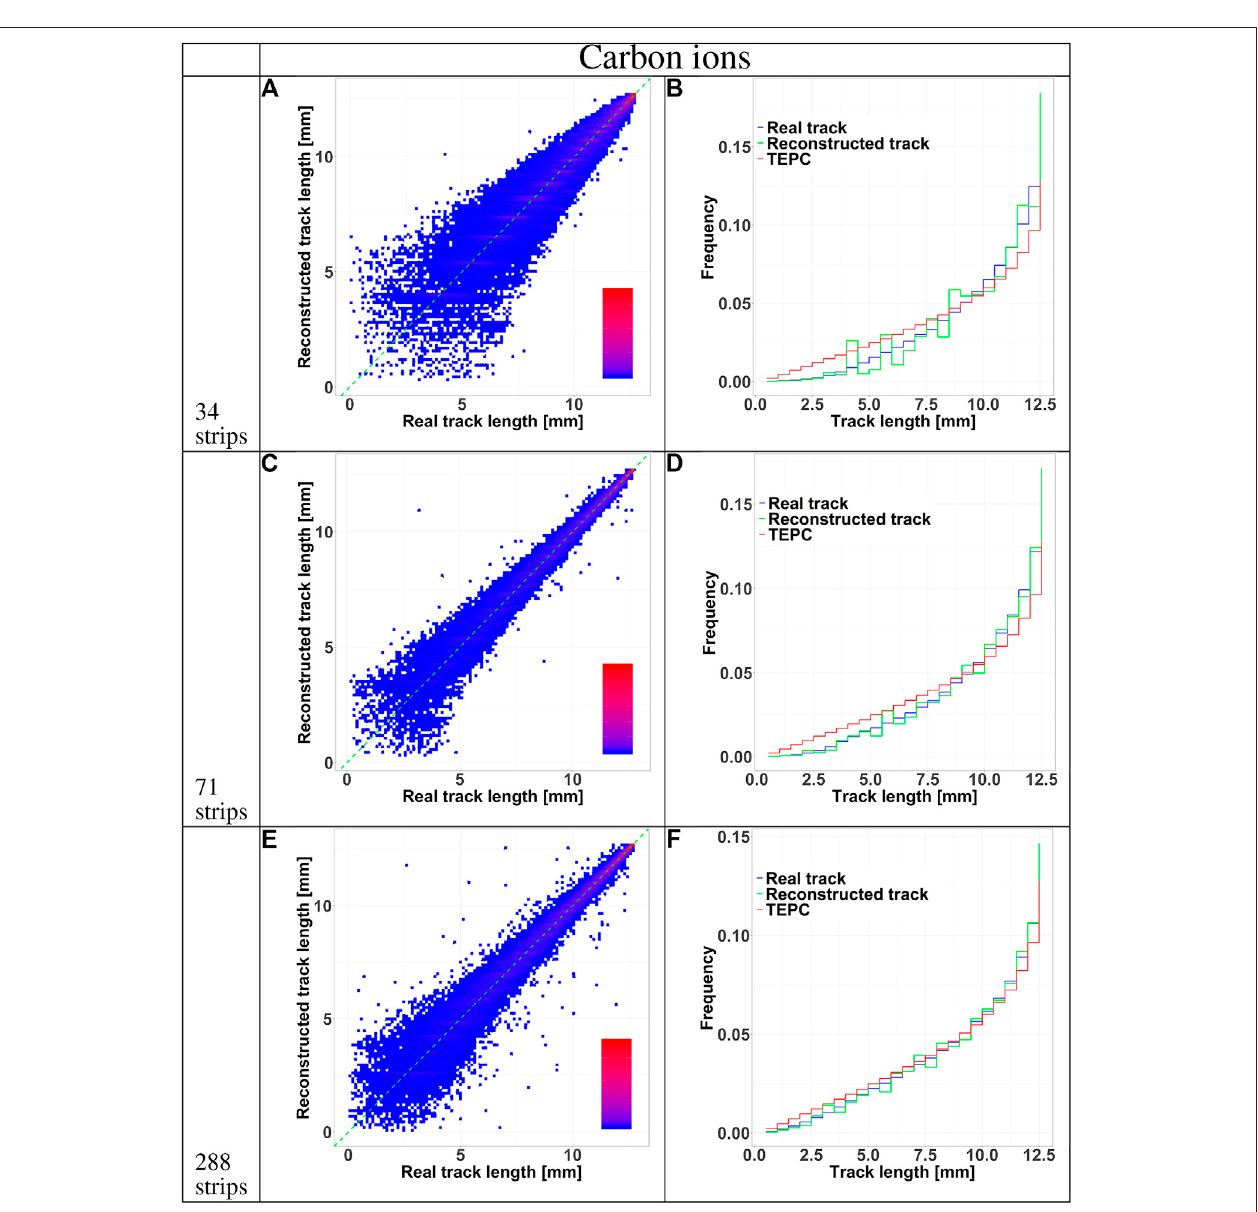
FIGURE 7 | HDM performances when exposed to 290 MeV/u carbon ions at 10.74 cm depth in water. The results are shown for 34, 71 and 288 strips LGAD con fi gurations. Panels A, C, E shows 2D color plotsof track length obtained withHDM versusreal track length calculated directly withGeant4.The green dashed lineat 45 degrees indicates the perfect agreement between the two datasets. The colors represent regions with a high (red) or low (blue) density of events. Panels B, D, F illustrate the comparison between the track length distributions of particles tracked by HDM considering the real track lengths calculated with Geant4 (blue line) or that reconstructed with the tracking algorithm (green line). The distributions of the real track lengths obtained directly from the simulation is also shown (red line).